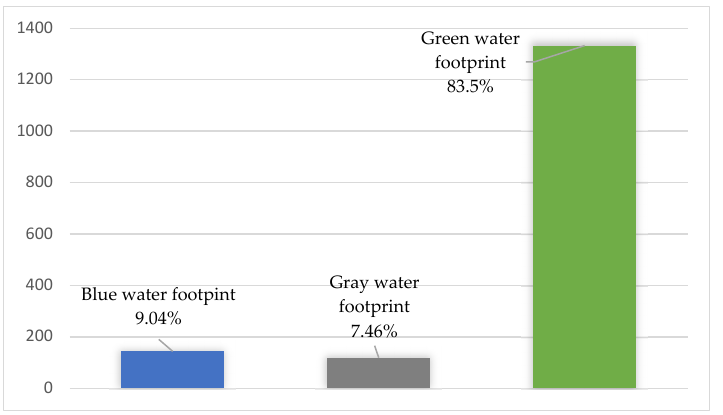
Figure 1. The structure of the food consumption water footprint of Romanian residents (m 3 inhabitant − 1 year − 1 ). The water footprint of residents’ food consumption by type is shown in Figure 2.